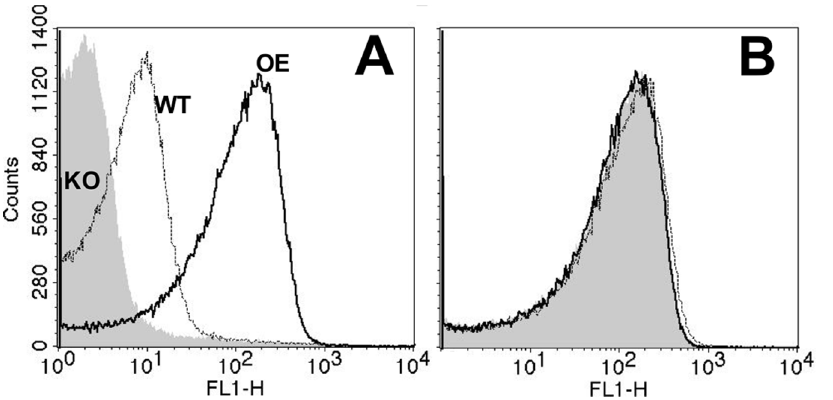
Figure 2. Surface-accessible fHbp on live bacteria of the mutant vaccine strain Sudan 1/06 with over-expressed fHbp as measured by flow cytometry. A. Binding of anti-fHbp mAb, JAR 5. WT, parental strain with wildtype fHbp expression; KO, mutant with fHbp gene inactivated; OE, strain with the engineered promoter and mutant gene encoding fHbp ID 9 with the R41S amino acid substitution. Panel B: Detection of MenW using anticapsular mAb JW-W1 as a control.